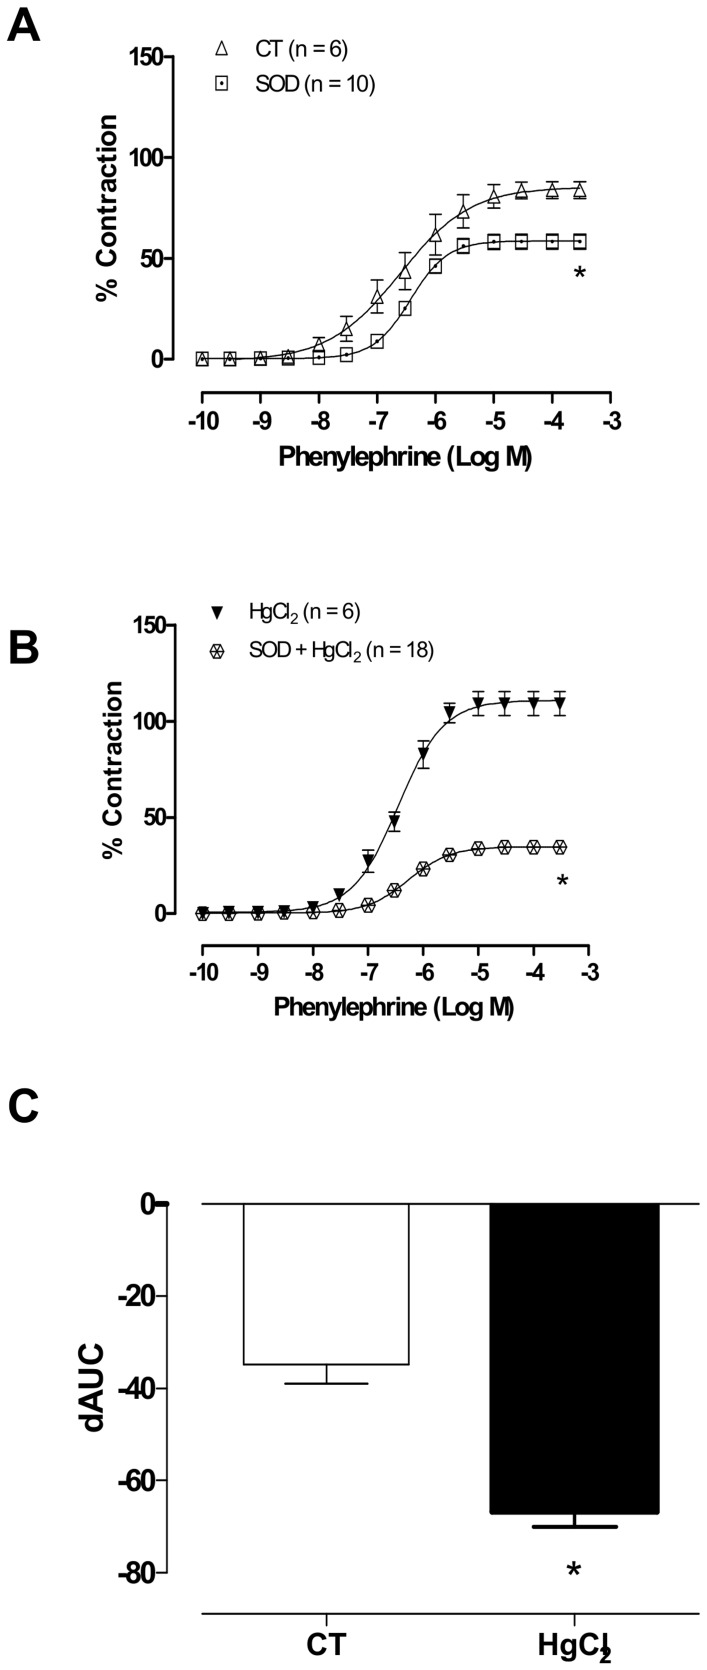
The effect of superoxide dismutase (SOD, 150 U ml−1
) on the concentration-response curves for phenylephrine in aortic rings in control (CT) conditions or HgCl2 (A,B).
Results (mean±SEM) are expressed as a percentage of the response to 75 mmol/l KCl. *P<0.05 by ANOVA. Number of animals used in parentheses. (C) Differences in the area under the concentration-response curve (dAUC) in aortic rings cultured in the presence and absence of superoxide dismutase (SOD, 150 U ml−1) under control (CT) conditions or HgCl2. *P<0.05 by Student’s t-test.